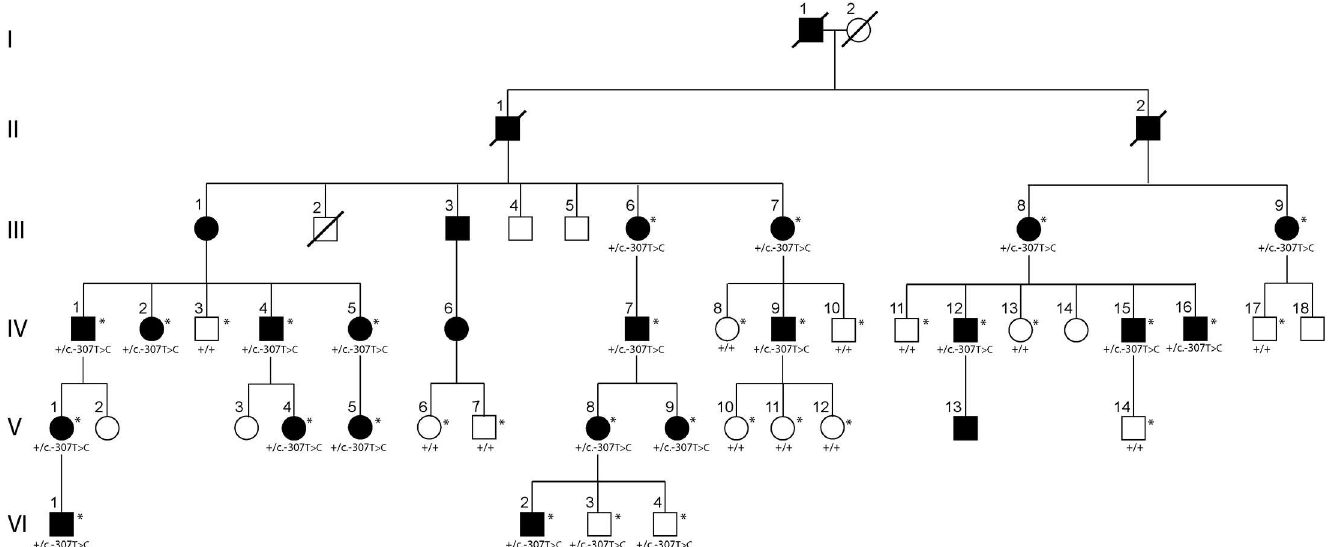
Fig 1. Pedigree of the original family mapped to the PPCD1 locus. Females are representedby circles, males by squares. Affected individuals are shown with filled symbols and unaffectedindividualsare shown with open symbols. Diagonallines across symbols indicateindividualswho are deceased. An asterisk ( * ) indicatesindividualswho underwent OVOL2 promoter screeningby Sanger